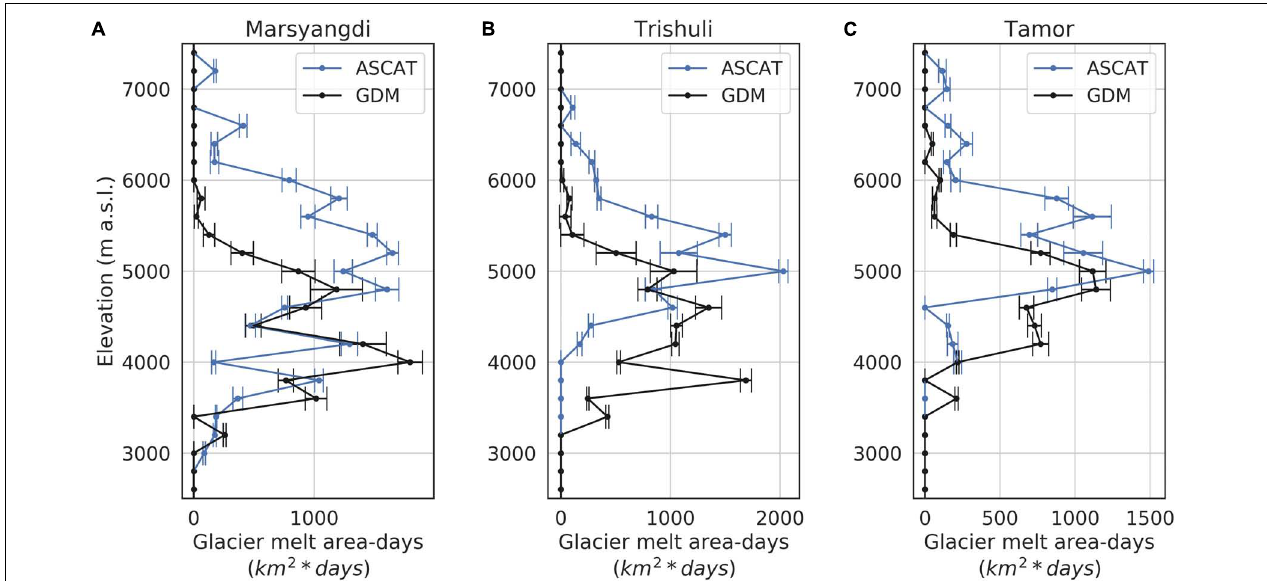
FIGURE 6 | The number of glacier melt-area days with elevation averaged over the years 2007-2010, with one standard deviation indicated with error bars, as estimated by the GDM and observed with the ASCAT Scatterometer for the (A) Marsyangdi, (B) Trishuli, and (C) Tamor River